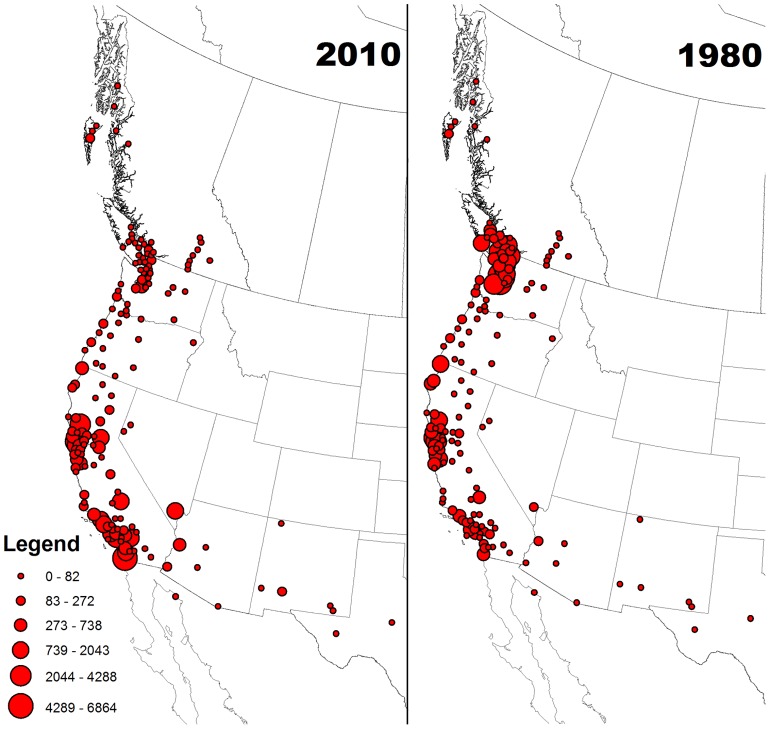
Distribution of non-breeding Aechmophorus grebes in 1980 and 2010.Each circle refers to an Audubon Christmas Bird Count used in the analysis and the size of the circle is scaled to the effort adjusted abundance of grebes on the count in that year. Combined data on western (Aechmophorus occidentalis) and Clark’s grebes (A. clarkii) were used in the figure but over 90% of observations are for western grebes in all regions except the southwestern states (see text for further detail).